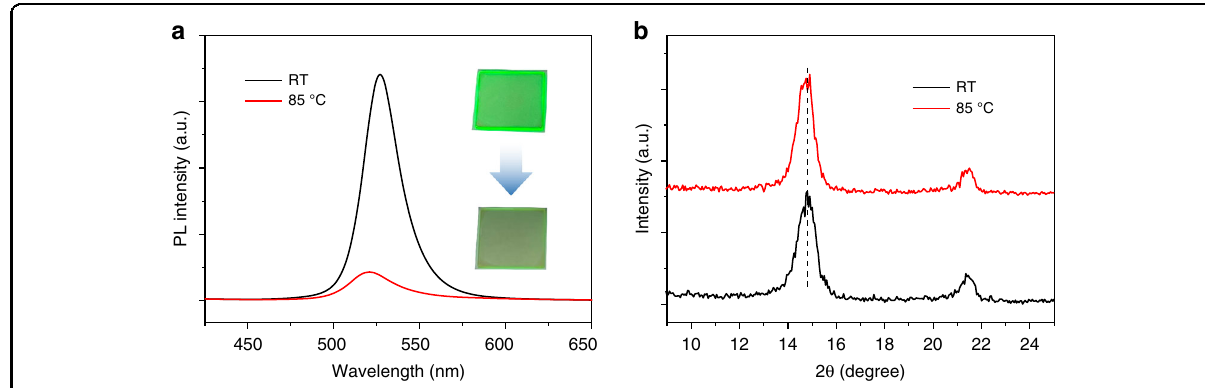
Fig. 1 Emission thermal quenching. a PL spectra and photographs of a quasi-2D perovskite fi lm excited at RT and 85 °C. b XRD patterns of perovskite fi lm measured at RT and 85